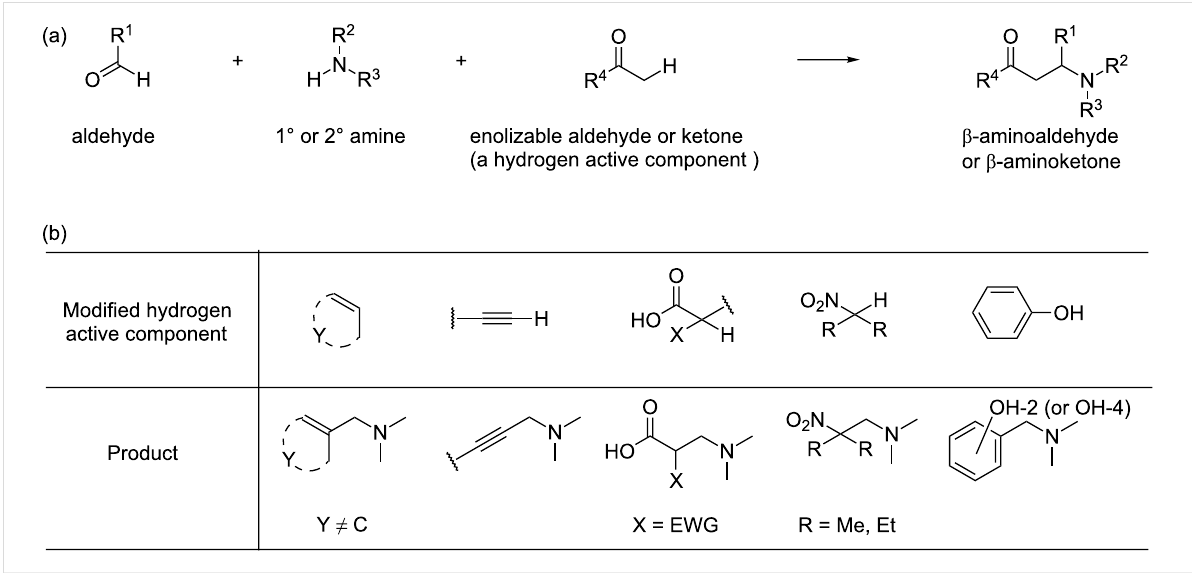
Scheme 1: (a) Classical Mannich reaction; (b) general structures of selected hydrogen active components and structures of the resulting Mannich reaction